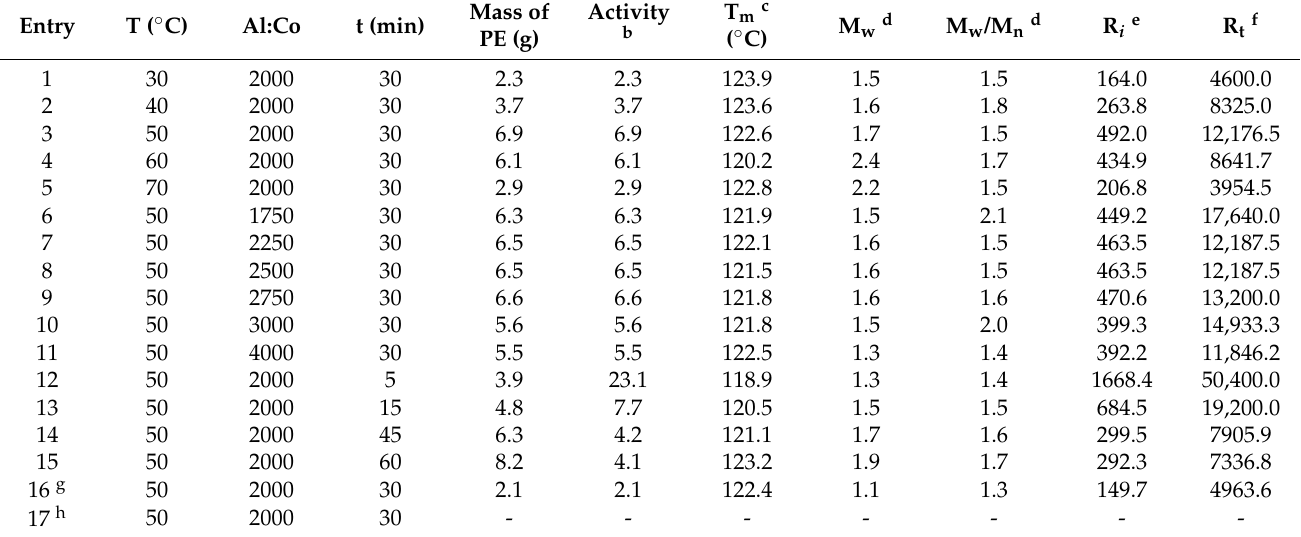
Table 2. Catalytic evaluation using Co6 /MAO as the test system a